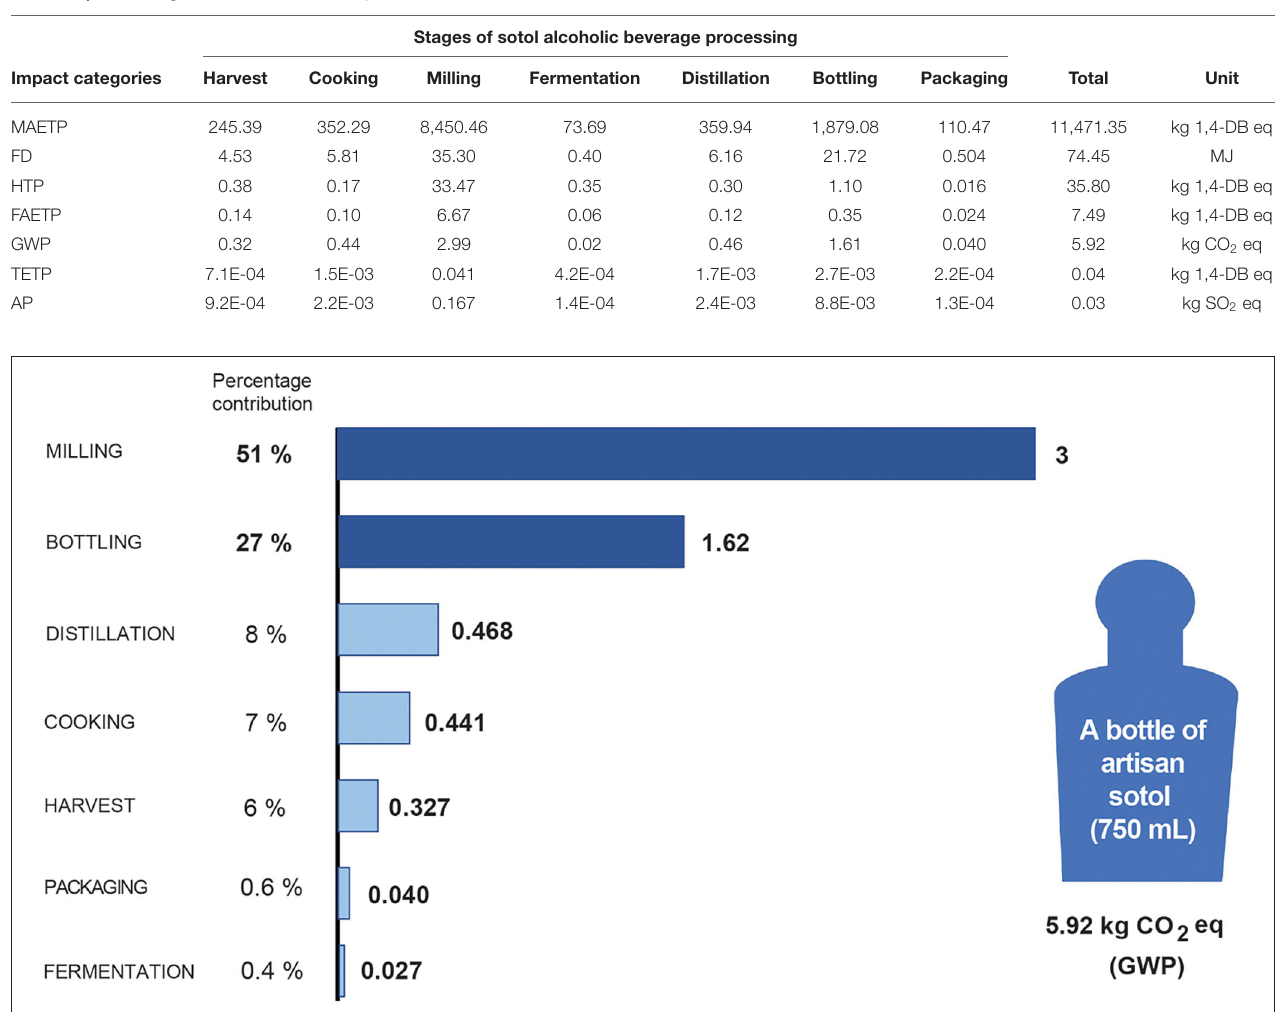
FIGURE 3 | Contribution details for each craft sotol processing process in the GWP (Global-warming Potential)